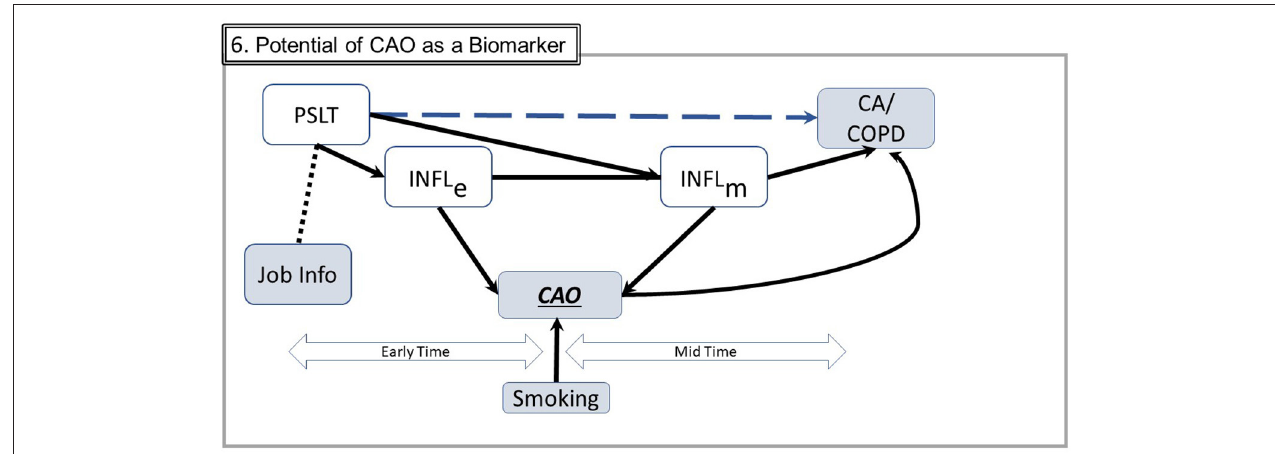
FIGURE 6 | Potential of CAO as a biomarker. This figure includes simplified elements from Figure 5 . CAO occurs both in the early and the mid times and therefore may be empirically ascertained throughout the long time from exposure to potential illness. In this figure, COPD is chronic obstructive pulmonary disease, a defined disease entity rather than a measurable trait such as CAO. Smoking, commonly the most important confounder, may generally be ascertained and subject to adjustment (Abbreviations are the same as in earlier figures; Several components from prior figures are not shown to facilitate graphical clarity).